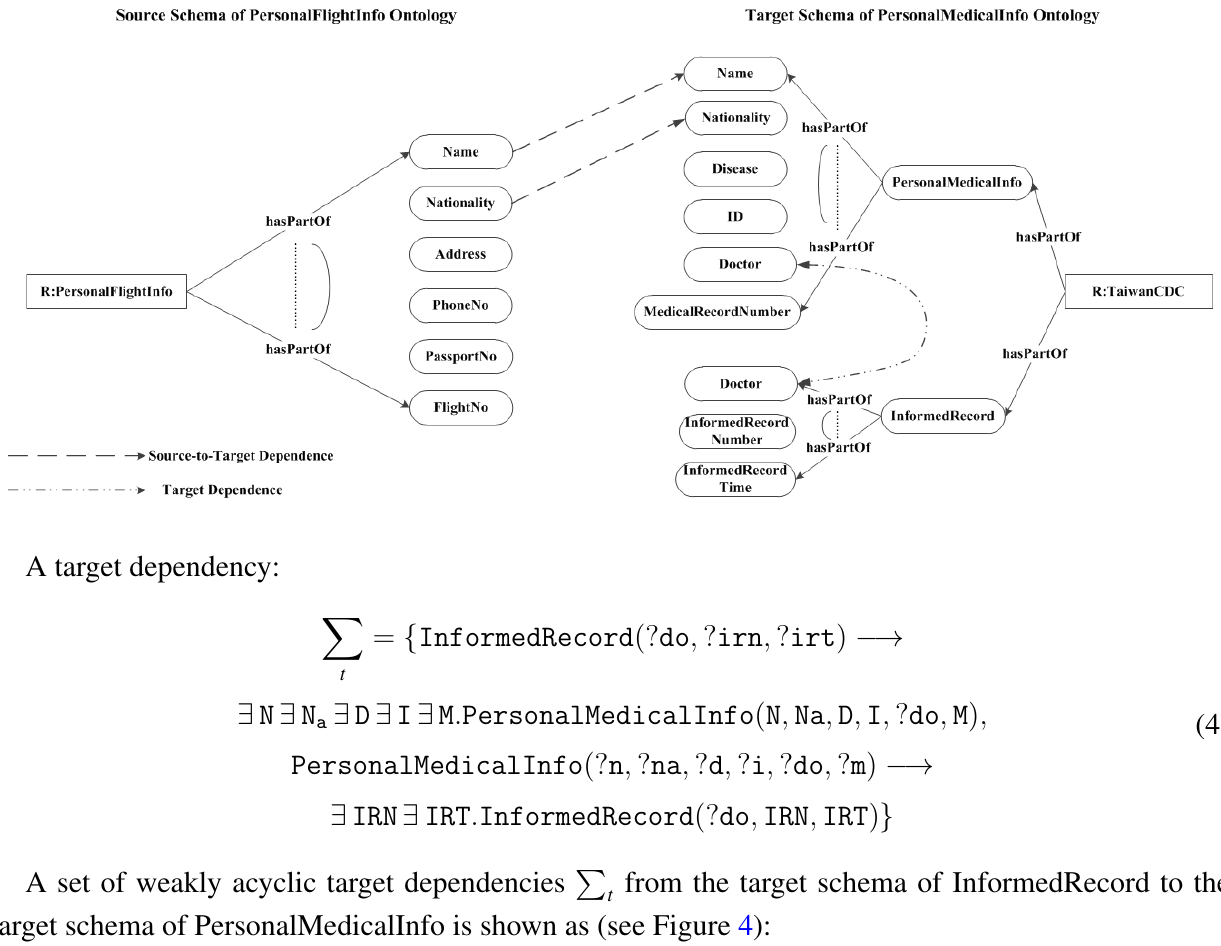
(cid:80) is defined from the source schema of personal st